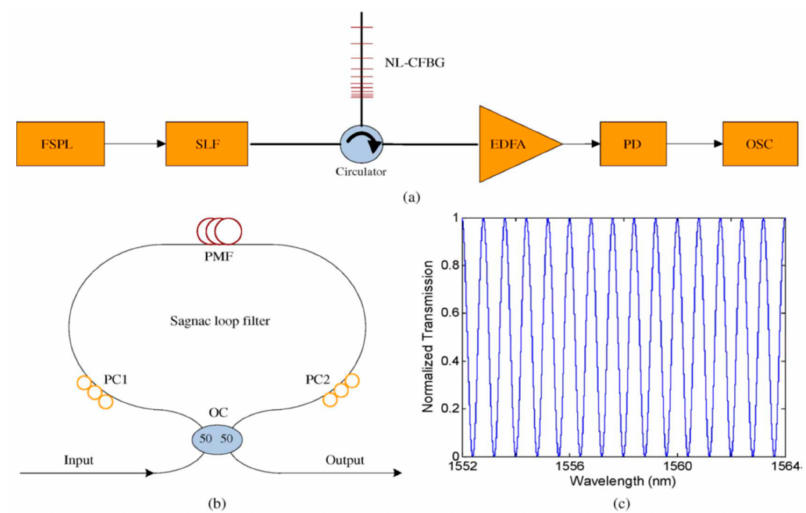
Figure 27. Experimental setup of the proposed chirped millimeter-wave pulse generation system. ( a ) System configuration. ( b ) Two-tap SLF. ( c ) Normalized transmission response of the SLF. Adapted with permission from ref. [134]. © [2022]